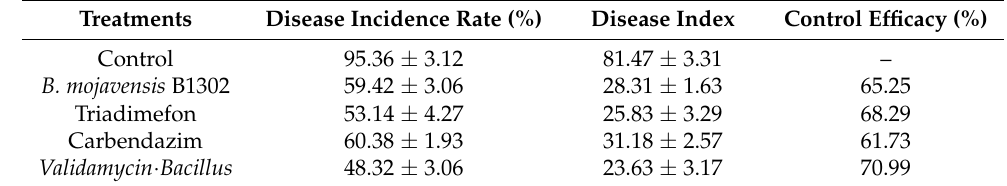
Table 7. Promotion of different treatments on the growth of wheat seedlings. Table 8. Biocontrol efficacy of different treatments on wheat sharp